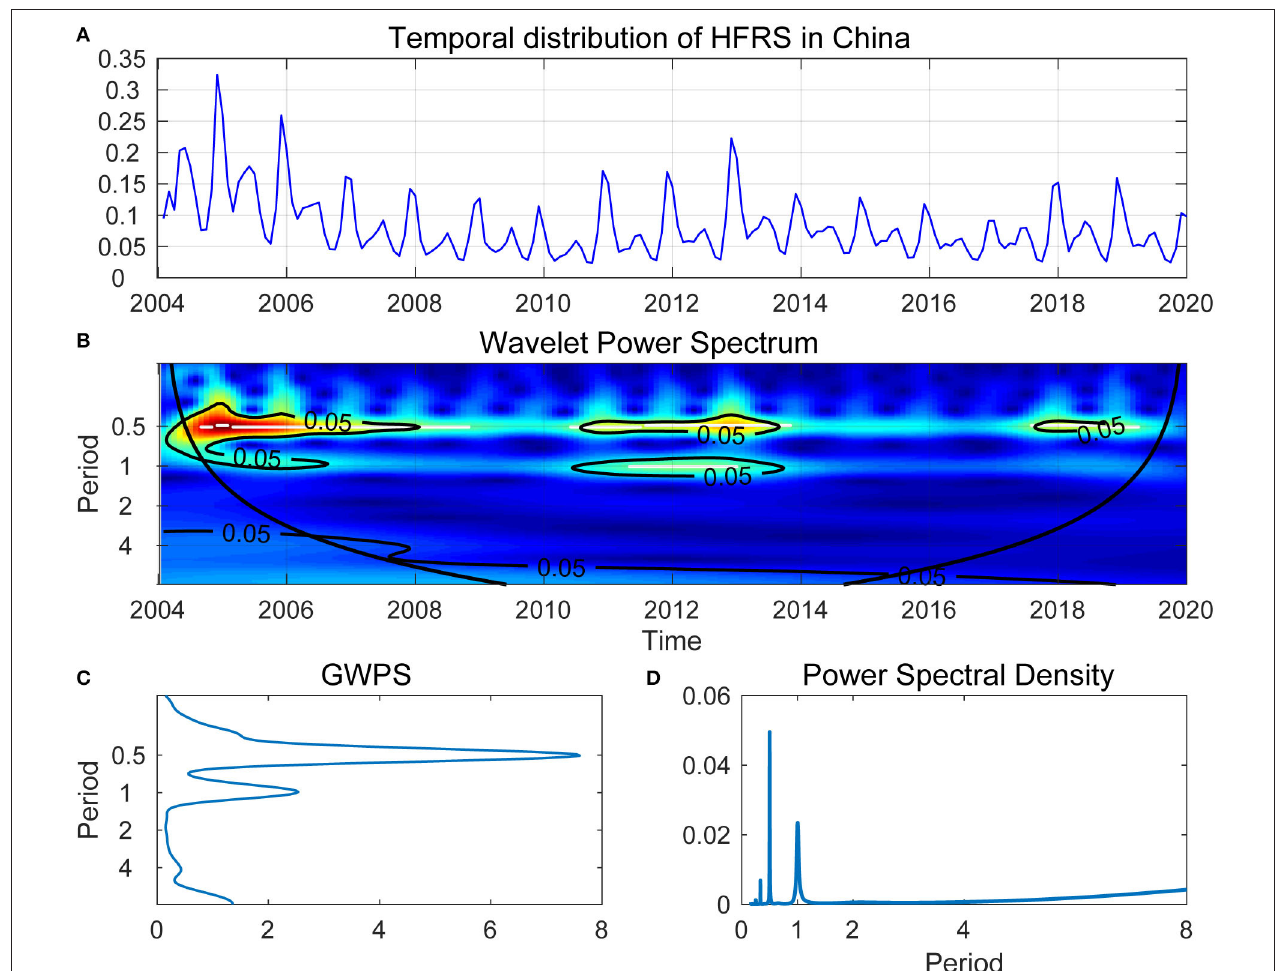
FIGURE 4 | (A) Temporal distribution of HFRS in China. (B) Wavelet Power Spectrum (WPS) of the reported monthly HFRS outbreaks. The cone of influence was separated by thick black lines, indicating the regions affected by edge effects. The color code for power ranged from blue (low power) to red (high power). The white lines showed the maxima of undulations in the WPS. (C) Global wavelet power spectrum (GWPS) of HFRS outbreak—average wavelet power for each frequency. (D) Fourier power spectral density of HFRS outbreaks, the peaks of power around half a year and 1 year can be observed in (C,D)